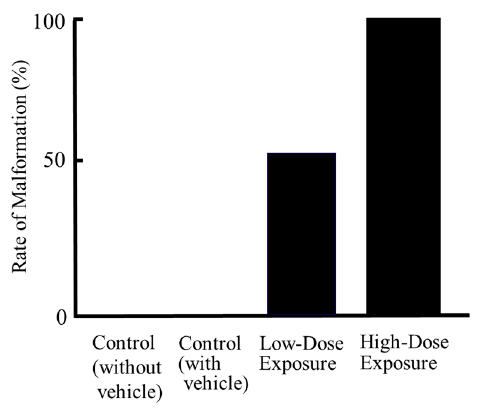
Figure 6. The rates of morphogenic abnormalities in rat embryos (n = 12) cultured for 48 h with low- and high-dose organohalogen contaminants from whale bacon. Number of embryos: control (without vehicle), 8; control (with vehicle), 8; low-dose exposure, 16; high-dose exposure, 17. The morphogenic abnormalities observed were abnormalities of the telencephalon, mandible or tail, including cleft lip, and craniofacial and forelimb hematomas.